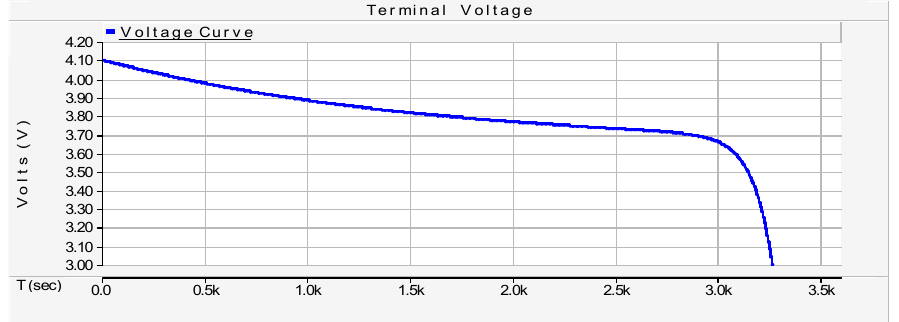
Figure 3. Change of terminal voltage to decrease in SOC along time axis.